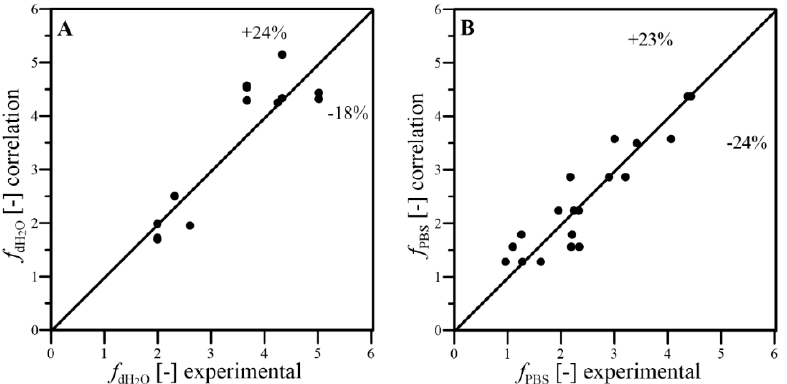
Figure 5. Parity plots of the f values predicted by dimensional correlations for dH 2 O ( A ) and PBS ( B ), i.e., based on Equations (9) and (10), respectively.